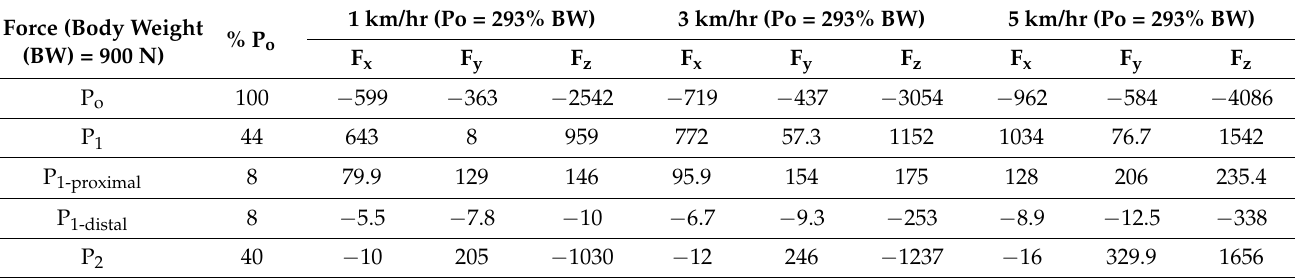
Table 3. Bodyweight and muscular loads for different walking speeds